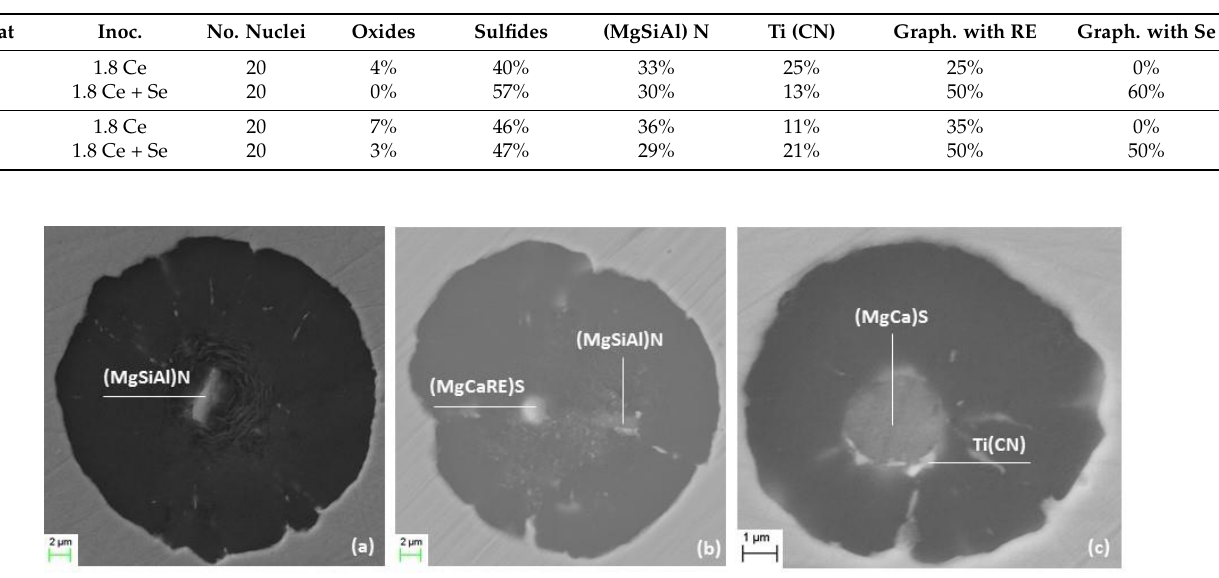
Figure 11. SEM images of a graphite nucleating on a selenide, and corresponding WDX/SEM spectrums, at different posi- tions: position 1 − (Mg,Ca) S; position 2 − (Mg,Se,Ca,Ce,La) S. These selenides can act as direct nucleation sites for graphite (Figure 11), or as nuclei for other nonmetallic inclusions (usually a complex of Mg-Si-Al-N). An example is illus- trated in Figure 12, where an analysis, using X-ray concentration graphs, reveals that Mg, Si, Al, and N show composition peaks at the same position. Then, S, Se, and Ca present a clear coincidental maximum. Thus, the nucleus of this graphite seems to be formed by a big polygonal Mg-Si- Al nitride (≥10 µm) that has nucleated on two small Ca sulfides and selenides, demonstrating the coexistence of both compounds, as discussed earlier.